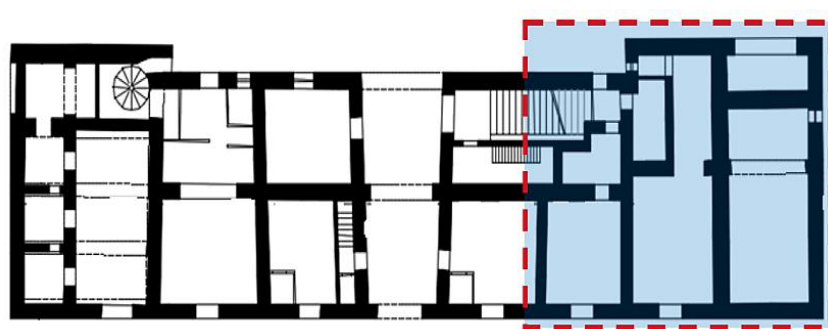
Figure 5. Heading structural unit in aggregate condition.